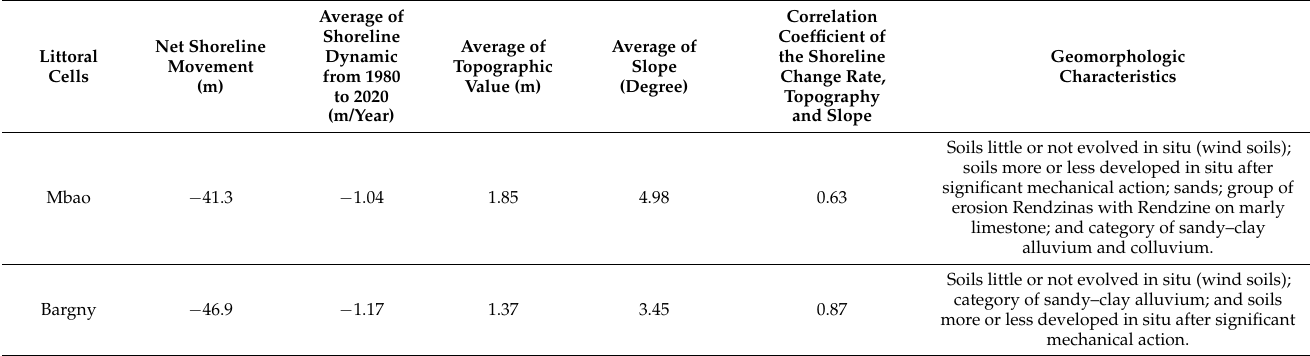
Table 4. Littoral cells, transect considerations and statistic